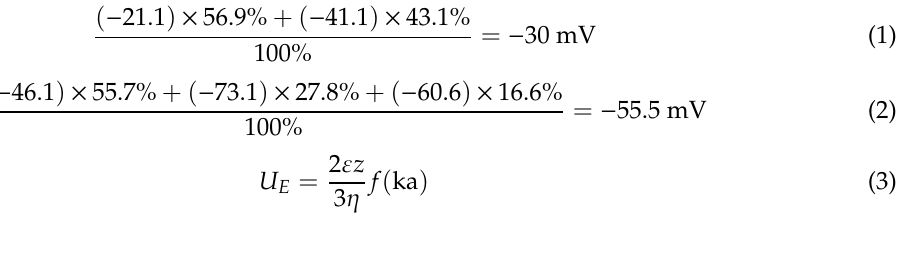
Table 1. Experimental parameters for using an electrical discharge machine (EDM) to prepare rGOAg. Pulse Discharge Dielectric Fluid Electrode Discharge Time Voltage Cycle (T on :T o ff ) GO dispersion Ag 2 min 140 V 30:30 us in water Atmospheric Volume of the Purity of the Diameter of the electrode pressure dielectric fluid electrode (Upper / Lower)